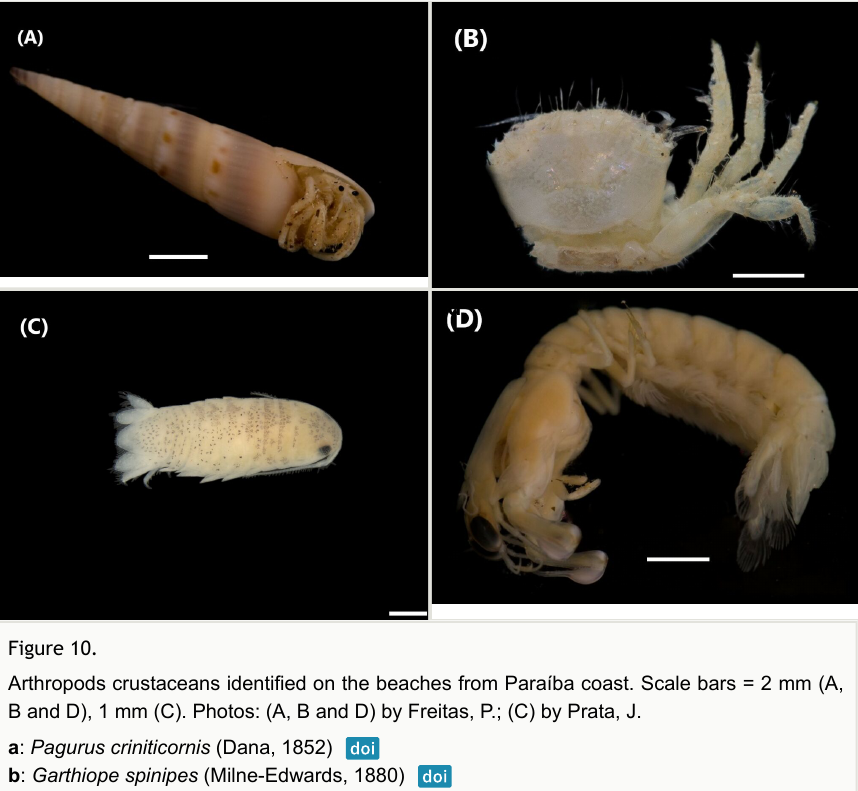
Figure 10. Arthropods crustaceans identified on the beaches from Paraíba coast. Scale bars = 2 mm (A, B and D), 1 mm (C). Photos: (A, B and D) by Freitas, P.; (C) by Prata,